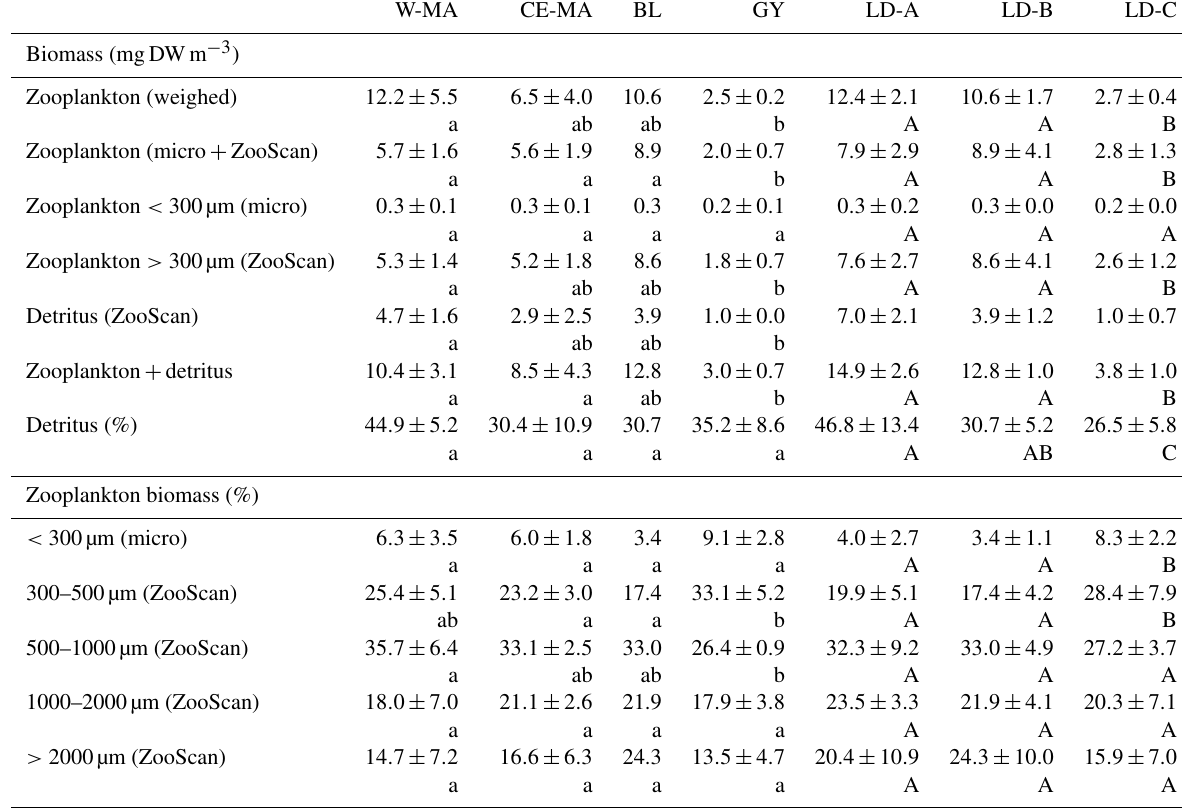
Table 3. Mean values ( ± standard deviation) among stations of each cluster defined in the PCA on environmental variables (see Fig. 2) of zooplankton biomass (top part of table, “Biomass (mgDWm − 3 )”) and percentage of total biomass for the different size fractions (bottom part of table, “Zooplankton biomass (%)”) and for the three long-duration stations. Zooplankton biomass estimated from weighing and from biovolume measurements from microscope and ZooScan observations. W-MA: western Melanesian archipelago; CE-MA: central and eastern Melanesian archipelago; BL: station B (blooming conditions); GY: subtropical gyre. Letters below the mean values indicate homogeneous groups between zones (small letters) or LD stations (capital letters) according to post hoc Scheffé tests.